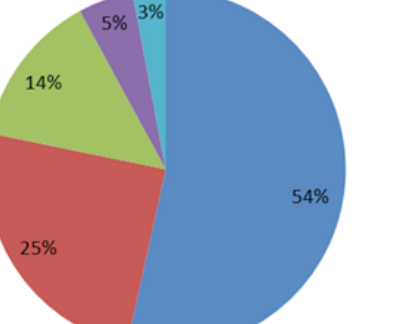
Figure 6: Reported activities undertaken subsequent